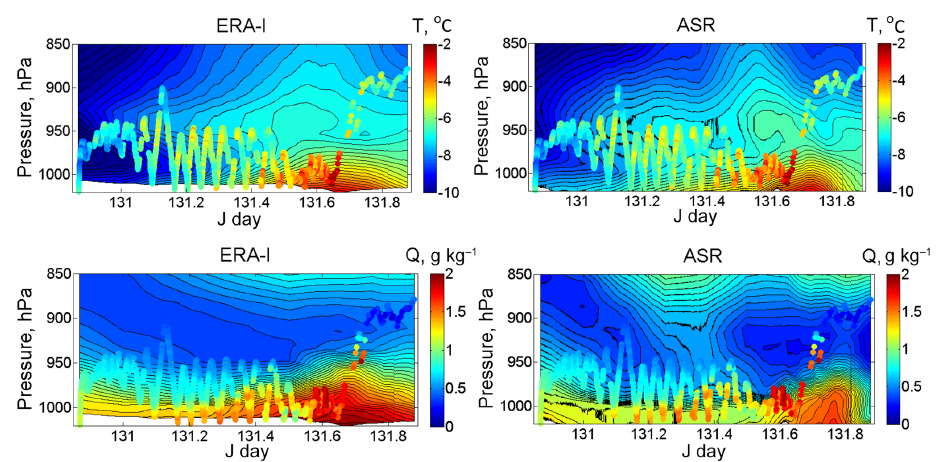
Figure 8. Temperature and specific humidity measured during the CMET flight 5 soundings (filled circles) compared to 4-D interpolated (latitude, longitude, pressure, time) model data from ERA-I and